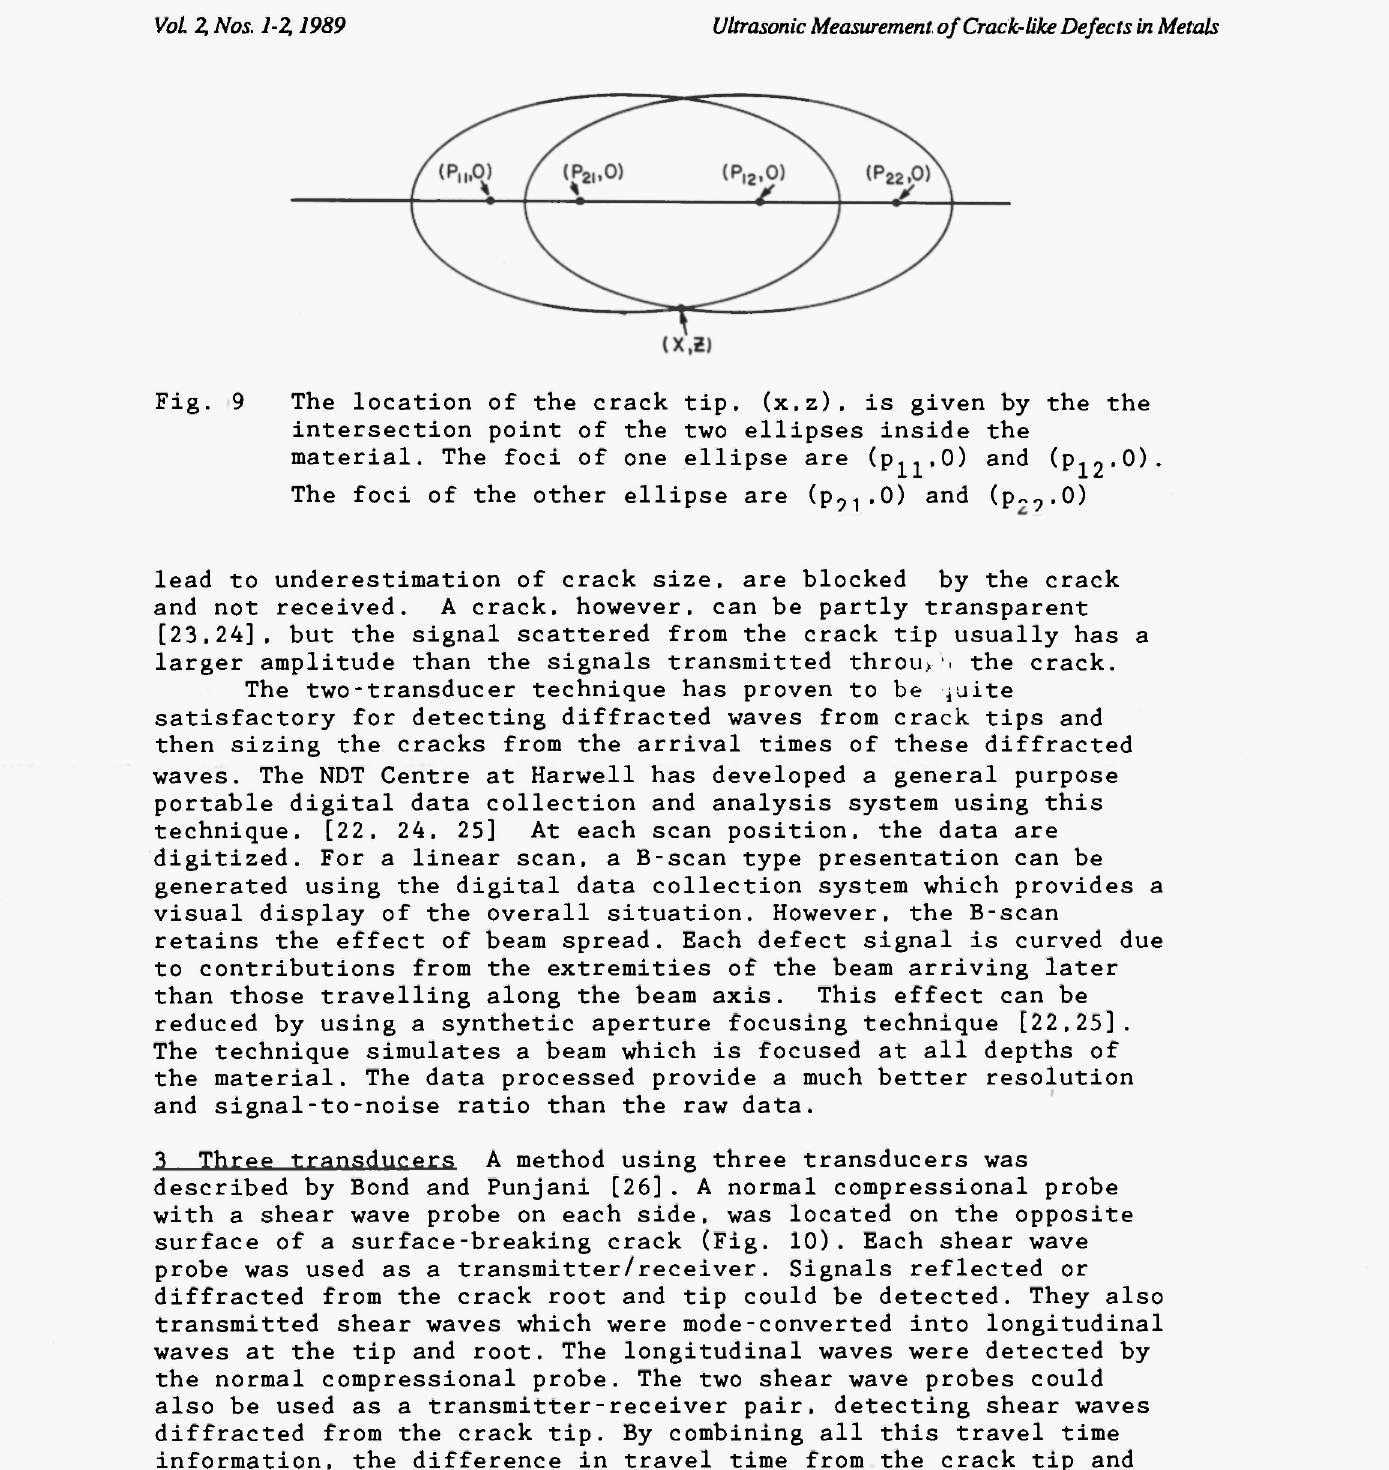
Fig. 9 The location of the crack tip. (x,z), is given by the the intersection point of the two ellipses inside the material. The foci of one ellipse are (p^.O) and (p 12> 0). The foci of the other ellipse are (p ?1 ,0) and (p„ 9